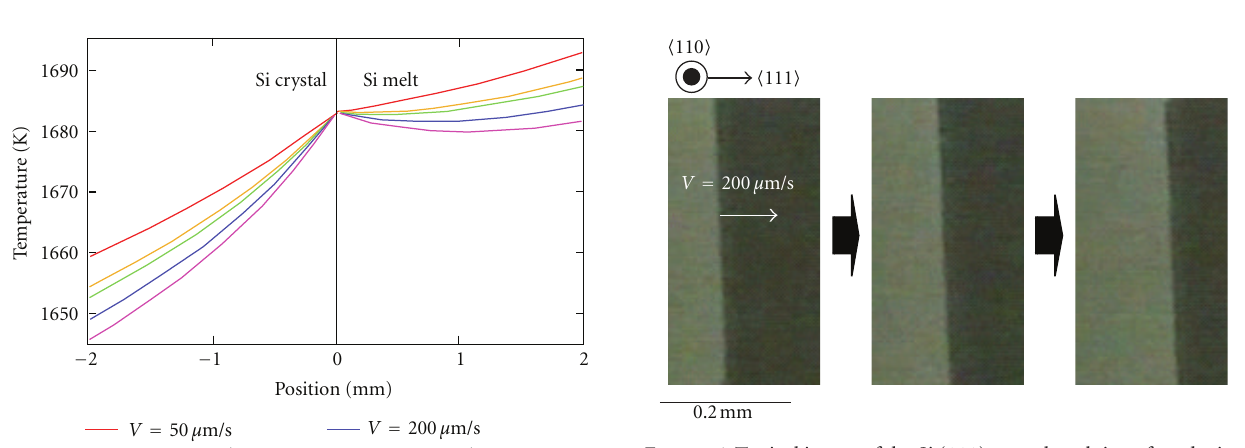
Figure 6: Typical image of the Si (111) crystal-melt interface during crystal growth